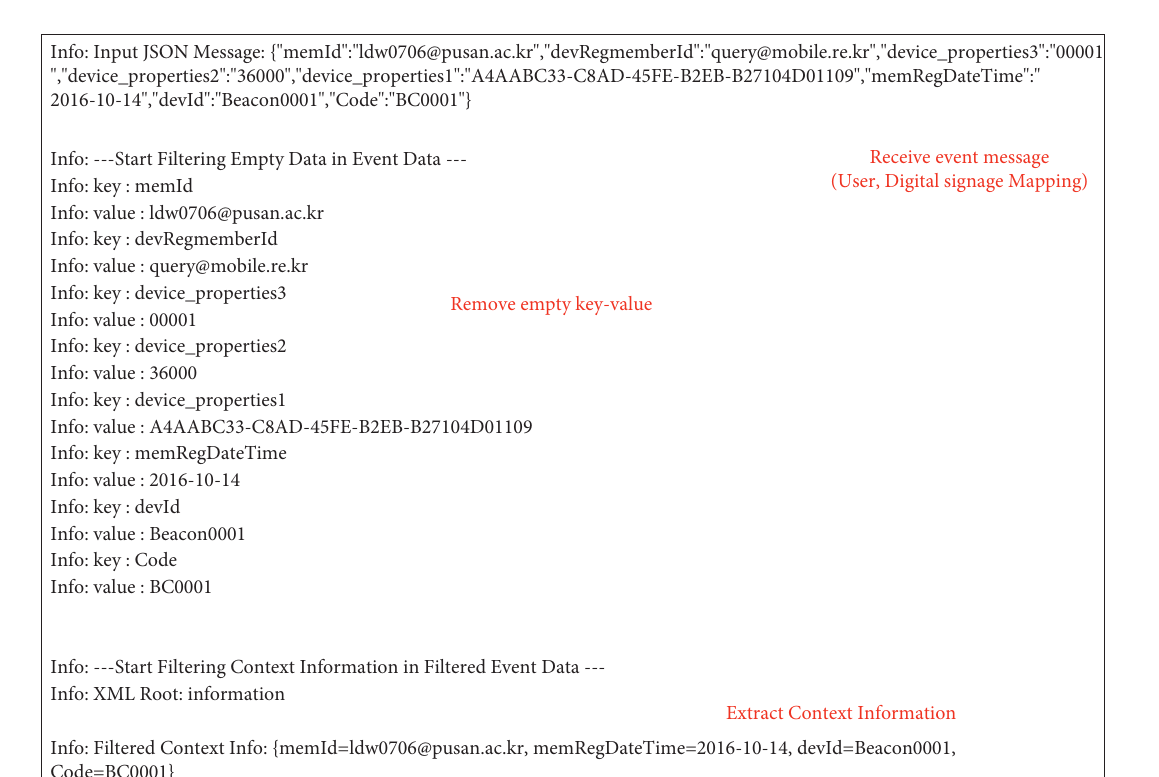
Figure 6: System log for the content service platform.